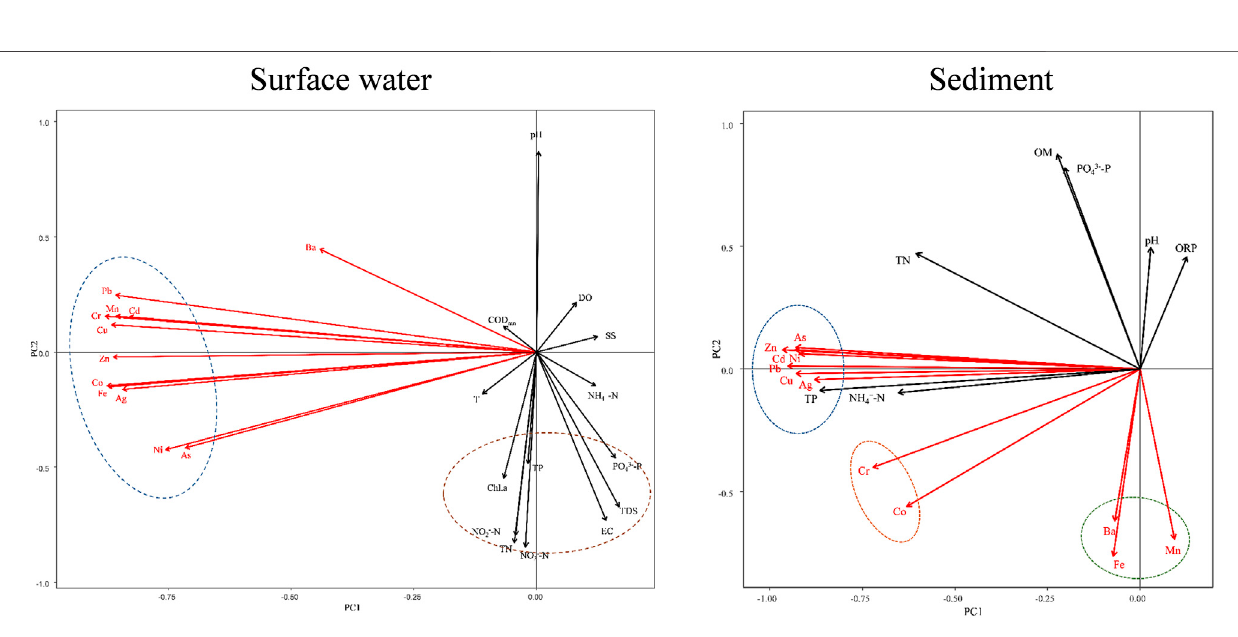
Frontiers in Environmental Science |